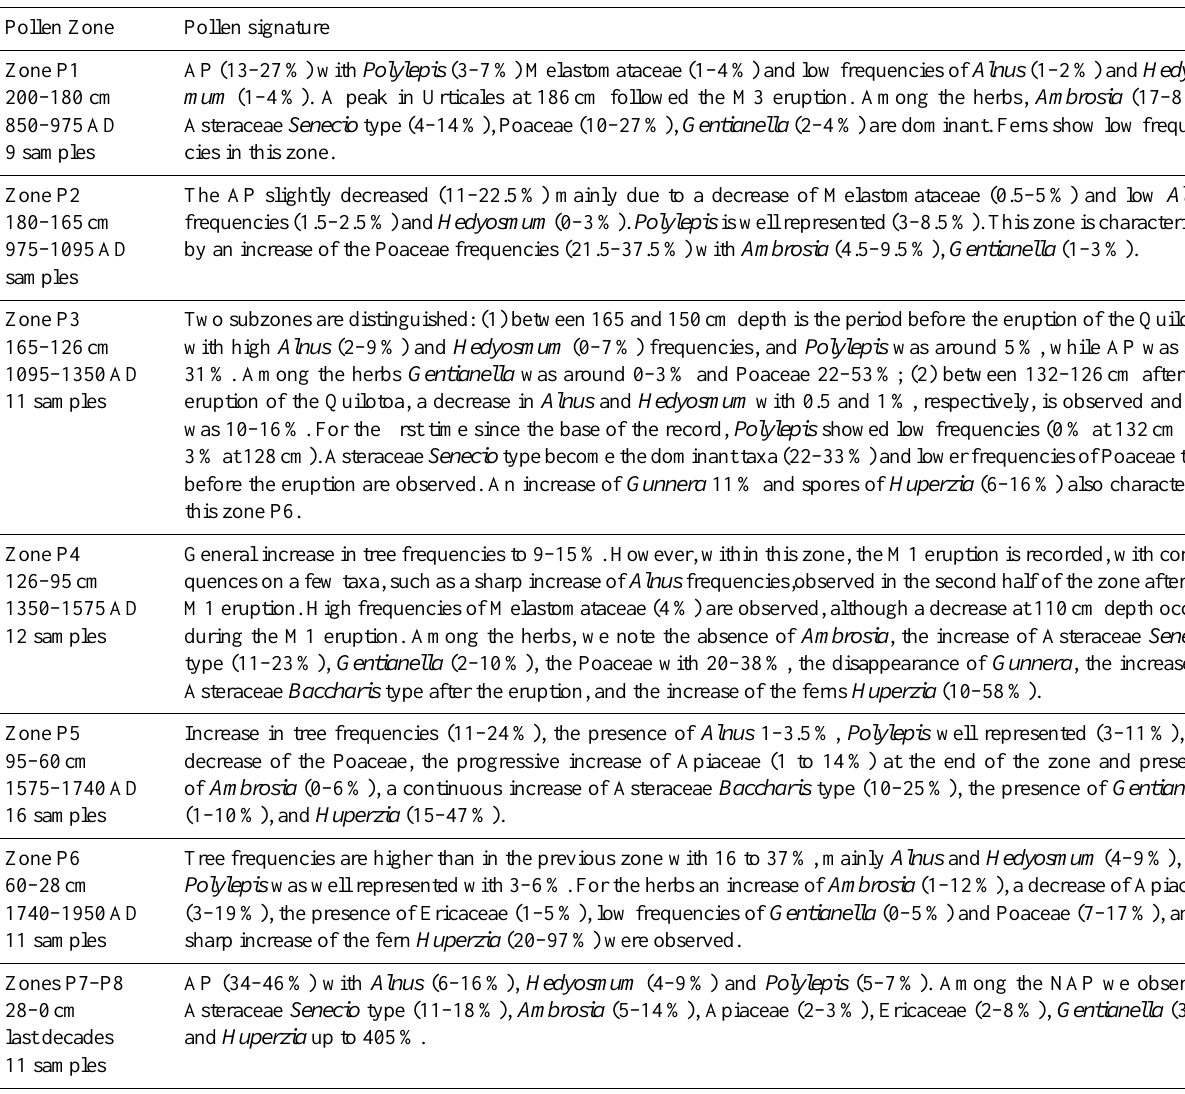
Table 3. Detailed description of the pollen zones defined in Fig.